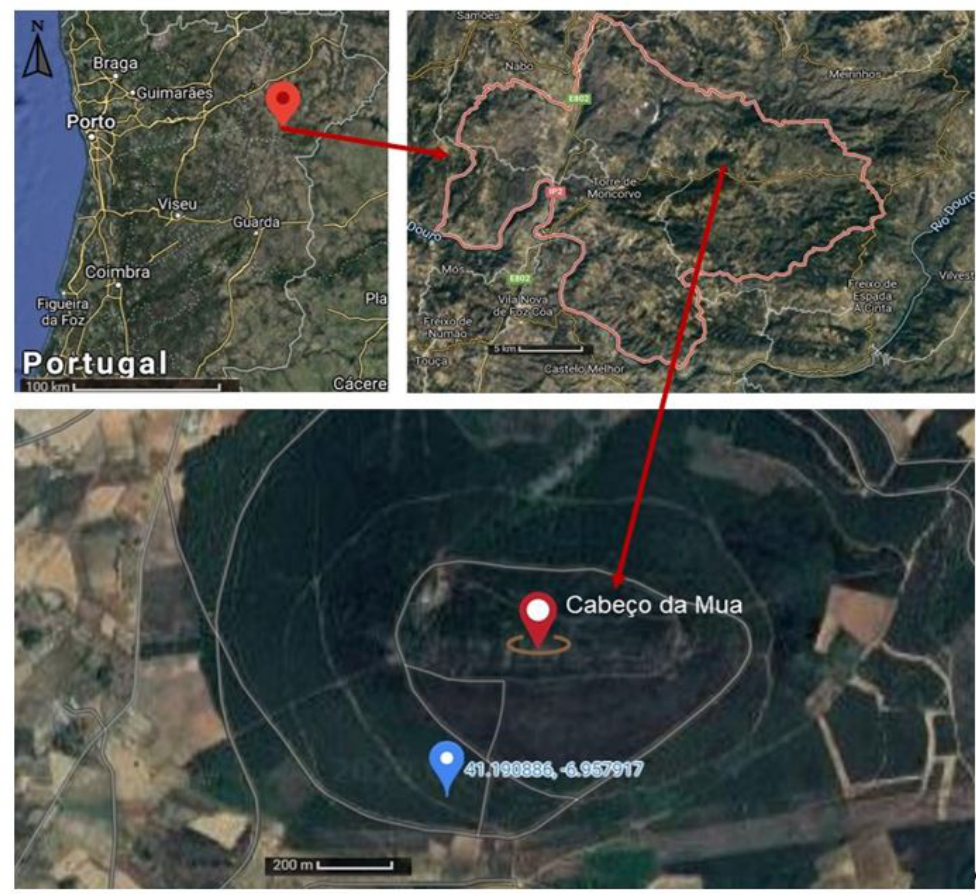
Figure 1. Location of the Cabeço da Mua hematite ore sampling area, Moncorvo. Images obtained from Google Maps.